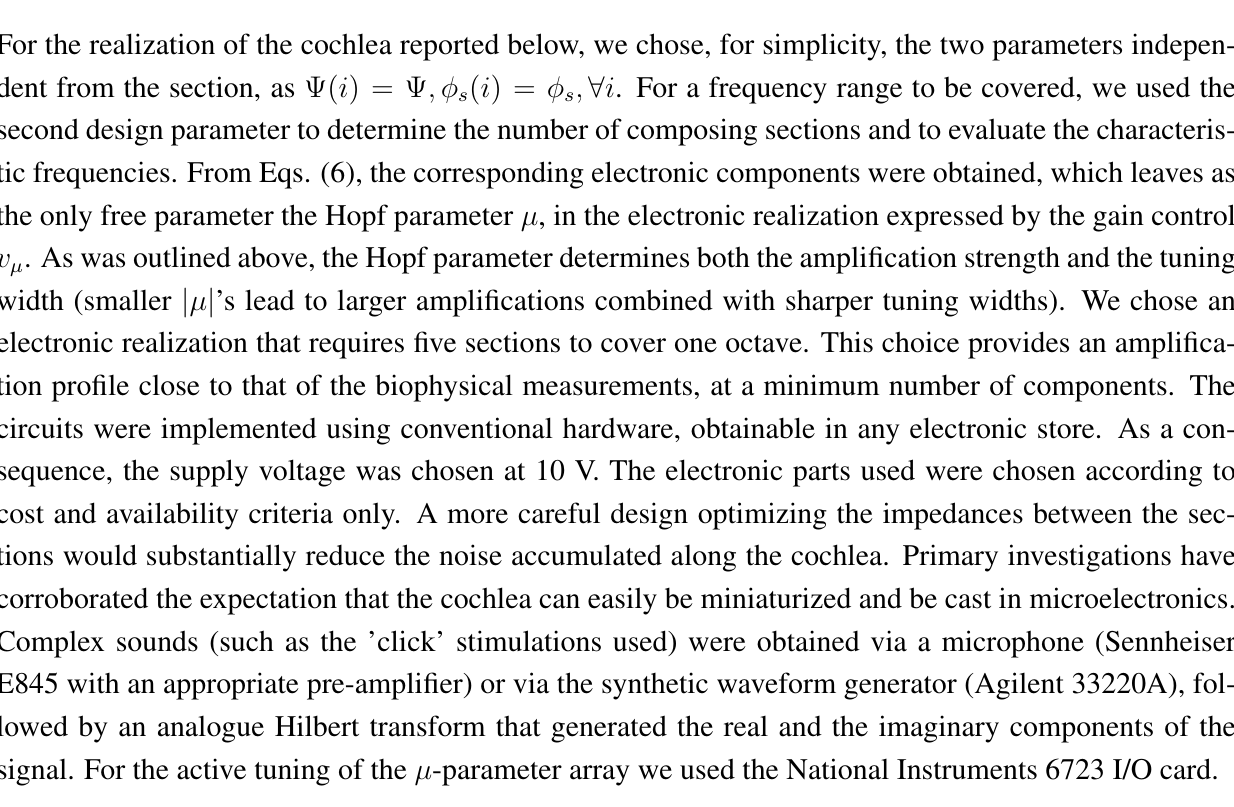
Figure 1 . Section diagram, consisting of a Hopf amplifier and two 6 th -order Butterworth filters. To form the cochlea, the sections are connected in